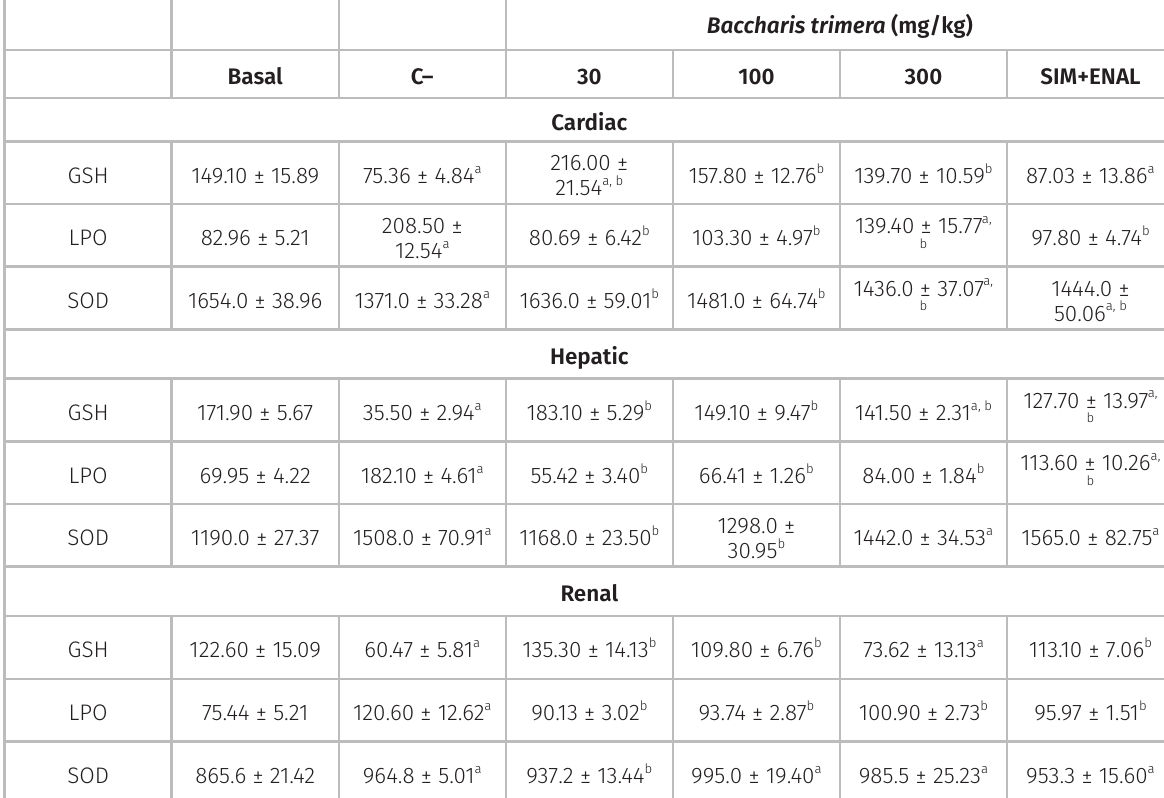
Table II. Cardiac, hepatic, and renal markers of oxidative stress in hypertensive, dyslipidemic, and smoker Wistar rats that were treated with vehicle, Baccharis trimera , and simvastatin +